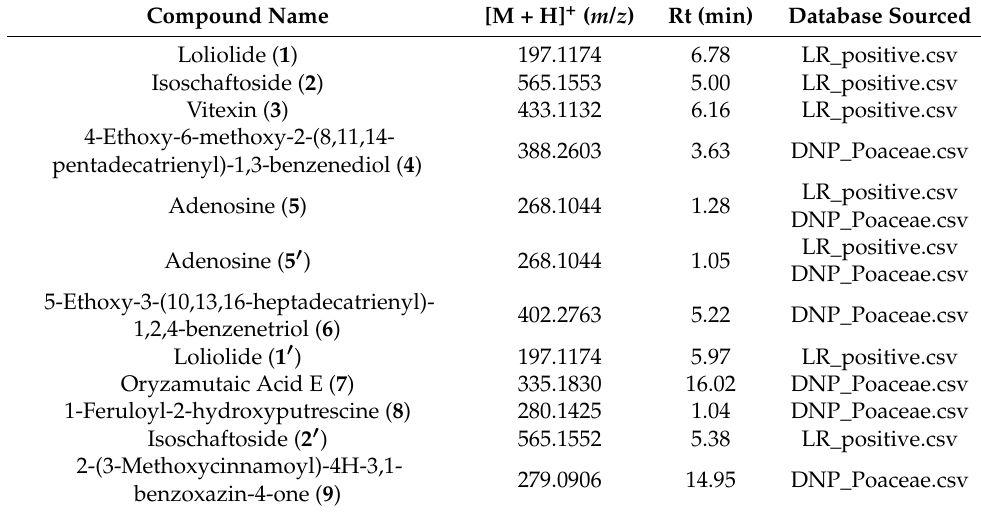
Table 1. Phytochemicals hit from the Custom-Built Database imported to MZmine